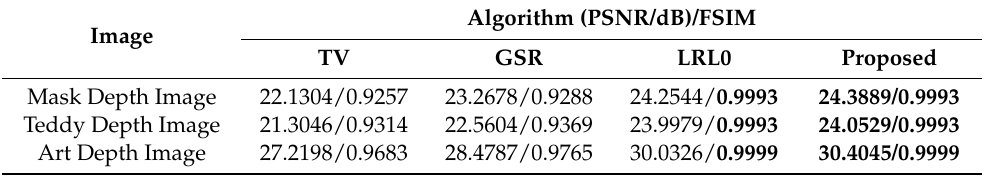
Table 1. Peak signal ‐ to ‐ noise ratio (PSNR) and feature similarity (FSIM) result in Experiment (1).